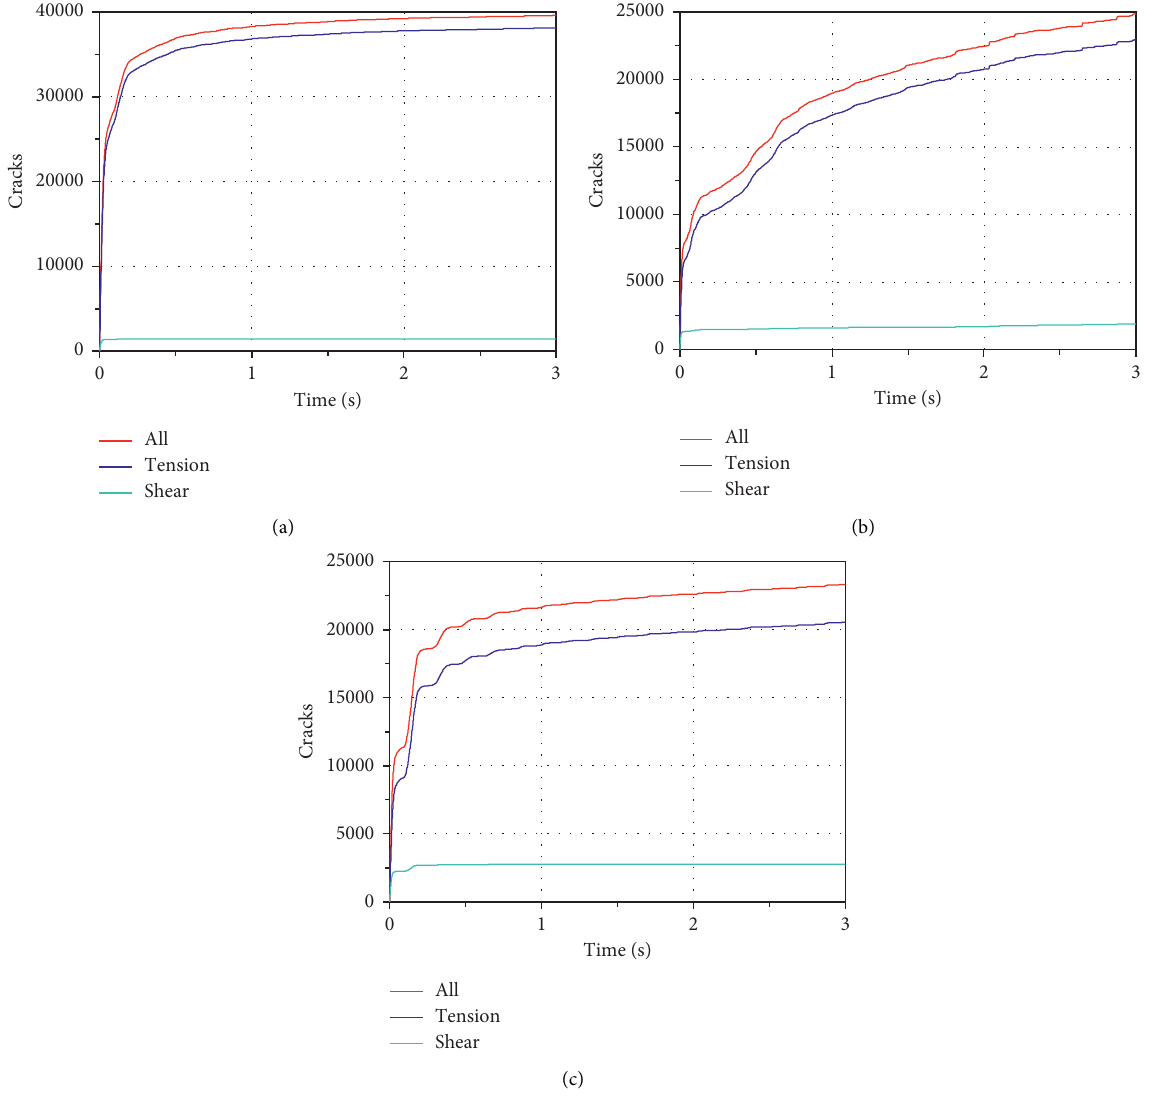
Figure 10: Fracture development curve. (a) For 5% moisture content. (b) For 8% moisture content. (c) For 12% moisture